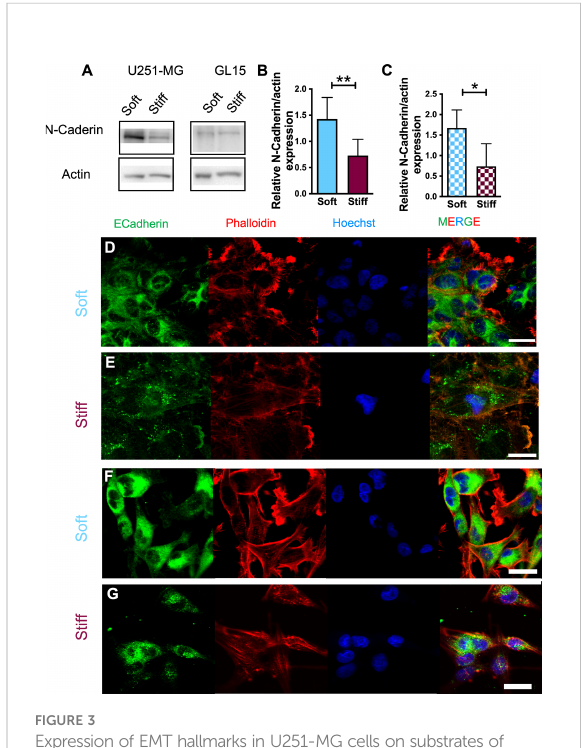
FIGURE 3 Expression of EMT hallmarks in U251-MG cells on substrates of different stiffness. (A) Representative western blot offour (n = 4) independent experiments and (B, C) relative quanti fi cation of N- Cadherin expression in U251-MG (B) and GL15 (C) cells on substrates of different rigidity. (D-G) Representative immuno fl uorescence images of U251-MG cells seeded on Soft (D) and Stiff (E) substrates and GL15 cells seeded on Soft (F) and Stiff (G) substrates. Cells were stained for phalloidin-TRITC (red), E-Cadherin (green) and Hoechst (blue). Scale bar 25 µm. Data presented as mean ± S.D. Student ’ s t- test was used for statistical analysis; *p < 0.05,